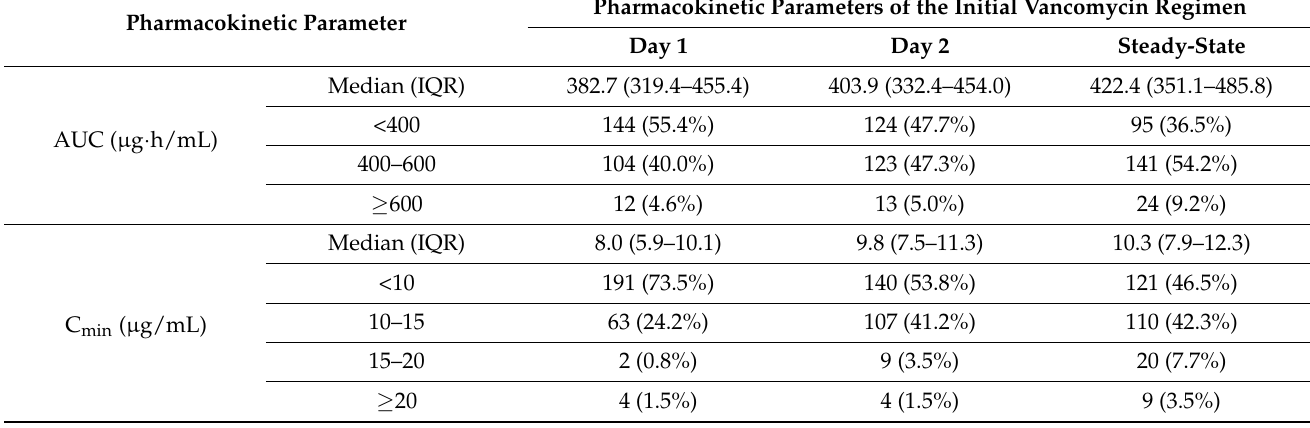
Table 1. AUC and C min on days 1–2 and at